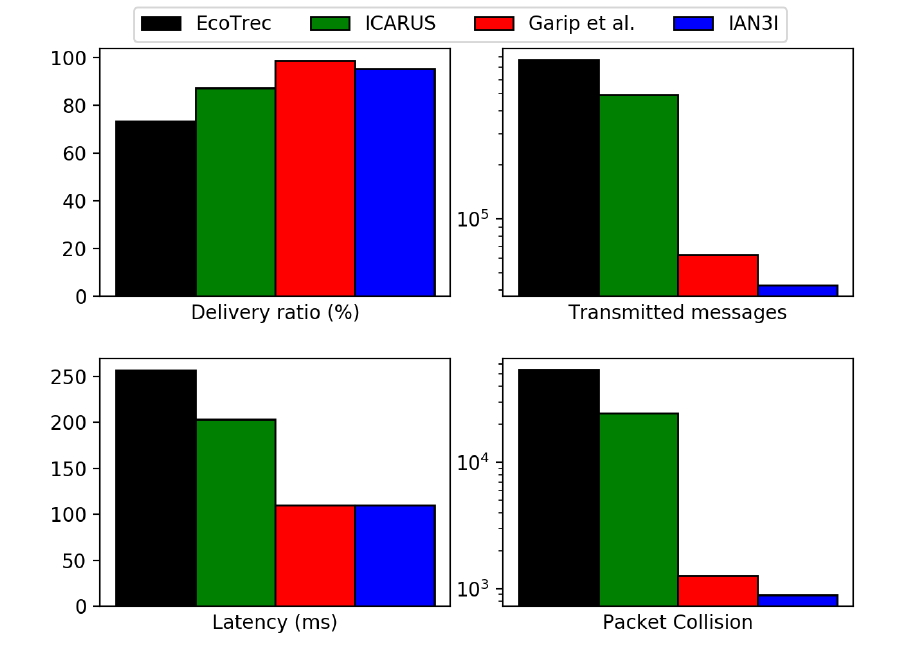
Figure 4. Results of network evaluation metrics for EcoTrec, ICARUS, Garip et al. and IAN3I when dealing with recurrent traffic congestion.